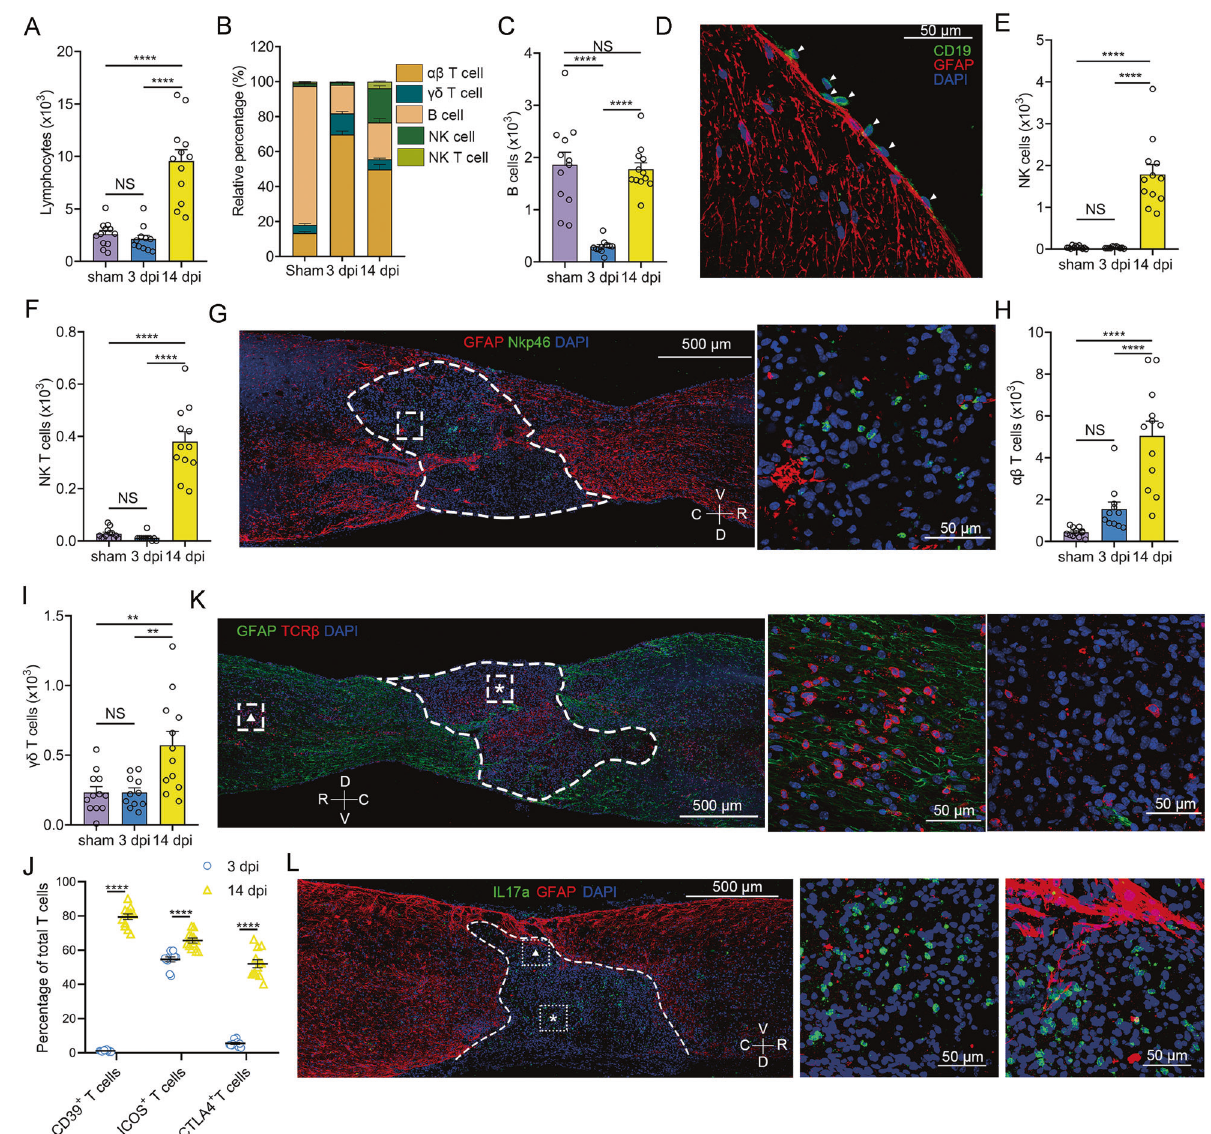
Fig. 2 Lymphocyte heterogeneity after SCI. A Flow cytometric analyses show the absolute number of lymphocytes per mouse after SCI. One- way ANOVA with Tukey ’ s multiple comparisons posttest, n = 11 mice in the 3 dpi group, n = 12 mice in the sham and 14 dpi groups, **** P < 0.0001. B Flow cytometric analyses show the proportion of αβ T cells, γδ T cells, B cells, NK cells, and NK T cells in lymphocytes per mouse after SCI, respectively. C Flow cytometric analyses show the absolute number of B cells per mouse after SCI. One-way ANOVA with Tukey ’ s multiple comparisons posttest, **** P < 0.0001. D An IHC image of a transverse section in the sham group shows the location of B cells (white arrows). Images indicate similar results from three independent mice. Scale bar: 50 μ M. E , F Flow cytometric analyses show the absolute number of NK cells E and NK T cells F per mouse after SCI, respectively. One-way ANOVA with Tukey ’ s multiple comparisons posttest, **** P < 0.0001. G IHC images of sagittal sections show the location of NK cells at 14 dpi. A dashed white line outlines the lesion border. An enlarged image of a dashed white boxed area is displayed on the right. Images indicate similar results from three independent mice. Scale bar: 500 μ M or 50 μ M. V, veutro; D, dorsal; R, rostral; C, caudal. H , I Flow cytometric analyses show the absolute number of αβ T cells H and γδ T cells I per mouse after SCI, respectively. One-way ANOVA with Tukey ’ s multiple comparisons posttest, **** p < 0.0001; ** P = 0.0025 (sham vs. 14 dpi); ** P = 0.0031 (3 dpi vs. 14 dpi). J Flow cytometric analyses show the percentage of activated T cells at 3 and 14 dpi per mouse. Multiple unpaired two-tailed Student ’ s t -test, ****P < 0.0001. K IHC images of sagittal sections showing the location of αβ cells at 14 dpi. A dashed white line outlines the lesion border. Magni fi ed images of the boxed area are displayed in the middle (asterisk) and right (triangle). Images indicate similar results from three independent mice. L IHC images of sagittal sections show the location of Th17 at 14 dpi. A dashed white line outlines the lesion border. Enlarged images of the boxed area are displayed in the middle (asterisk) and right (triangle). Images indicate similar results from three independent mice. Atp5e, Renbp, Ufm1, Tlr2, Cd5l, et al) (Fig. 3I). Enriched GO terms for Two clusters of PaMG were the predominant microglial subtypes the core genes showed that these PaMG genes were related to at three dpi (Fig. 3G). Analysis of DEGs compared to hMG showed oxidative stress and proliferation (Supplementary Fig. S6F). PaMG1 524 PaMG core genes (Cox5b, Mrpl30, Fn1, Cops9, Dbi, Rab7b, et al.), was closer to a proliferative state, whereas PaMG2 was closer to the 263 PaMG1 ’ s speci fi c genes (Mcm3, Sgo2a, Nop58, Nrp2, Acadl, reaction to oxidative stress (Supplementary Fig. S6G, H). Tuba4a, et al.), and 82 PaMG2 ’ s speci fi c genes (Mapkapk2, I fi 204,